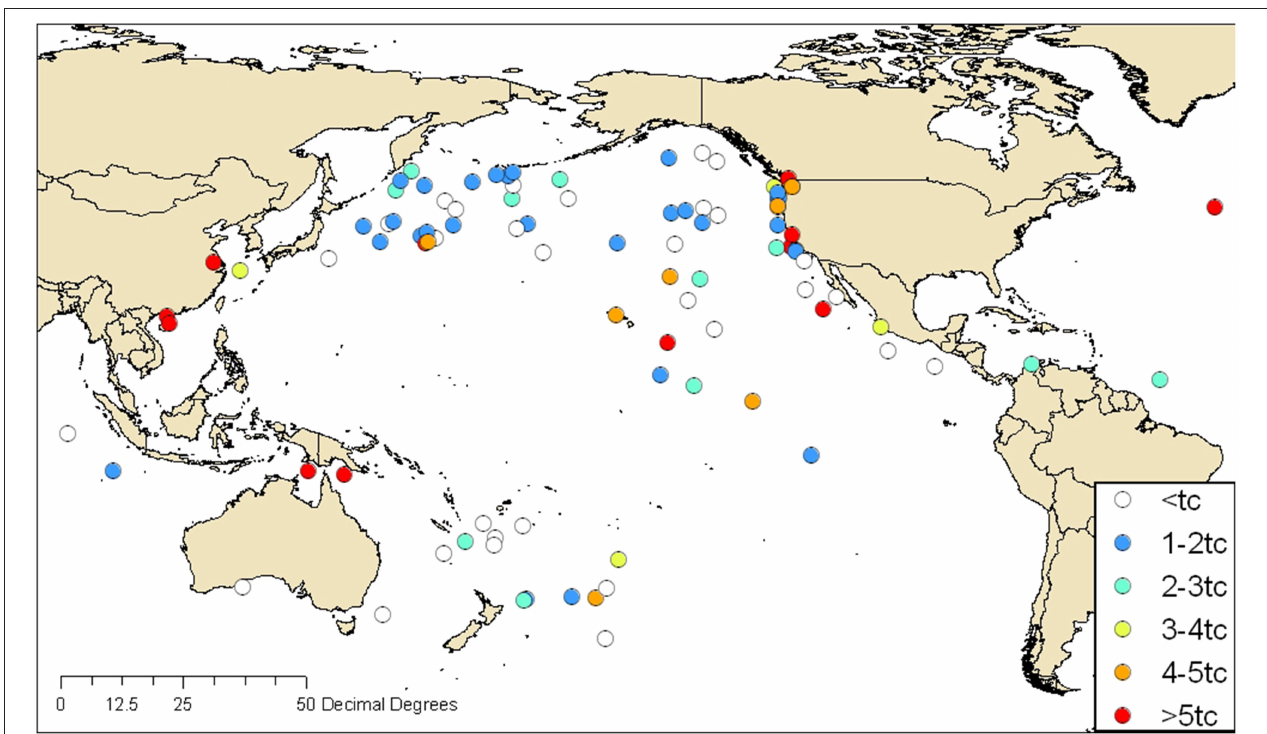
FIGURE 2 | FDOM fluorescence intensities (C3 * in QSE) in ships’ ballast water mapped according to the reported origin of ballast water. Symbols indicate intensities in multiples of the BWE threshold (0.7 QSE) developed by Murphy et al. (2006). Orange and red symbols indicate C3 * intensities that exceed the threshold by more than four and five times, respectively.